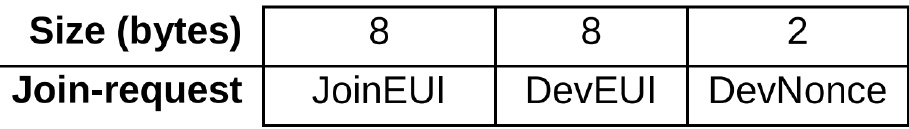
Figure 12. Structure of the PHYPayload of a join request